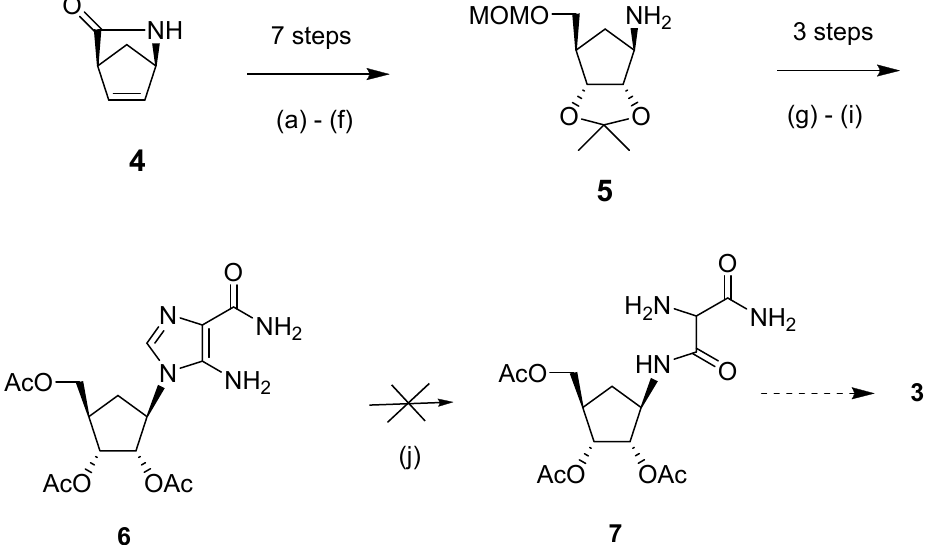
Scheme 2. The photochemical approach to the carbocylic analog of